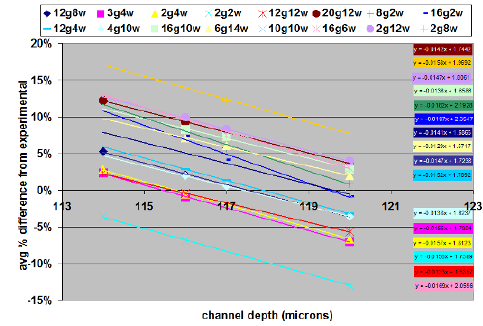
Figure 5. Comparison of analytical and experimental data to deter- mine channel depth